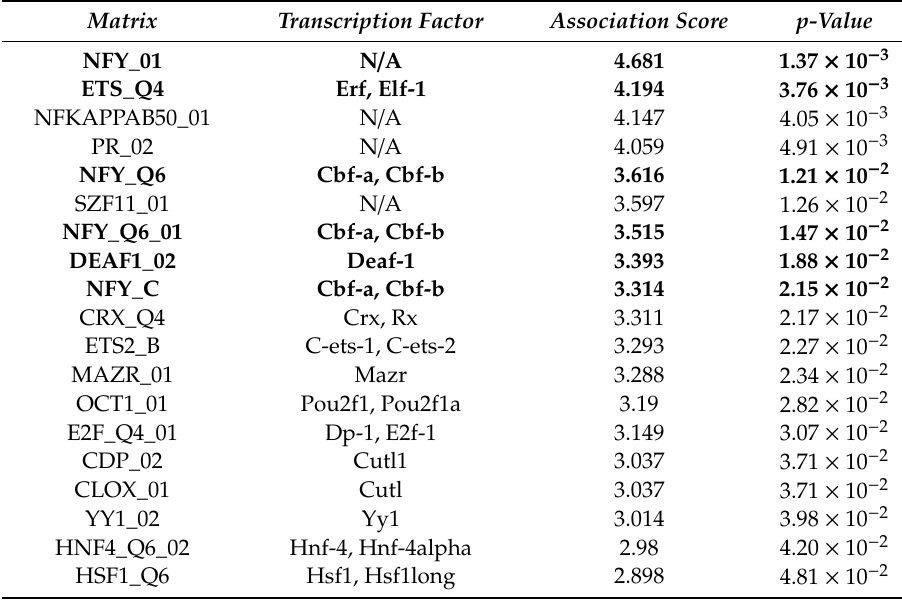
Table 2. Distal analysis ( ± − 10 kb) of genes a ff ected by ML114 in hPSCs.